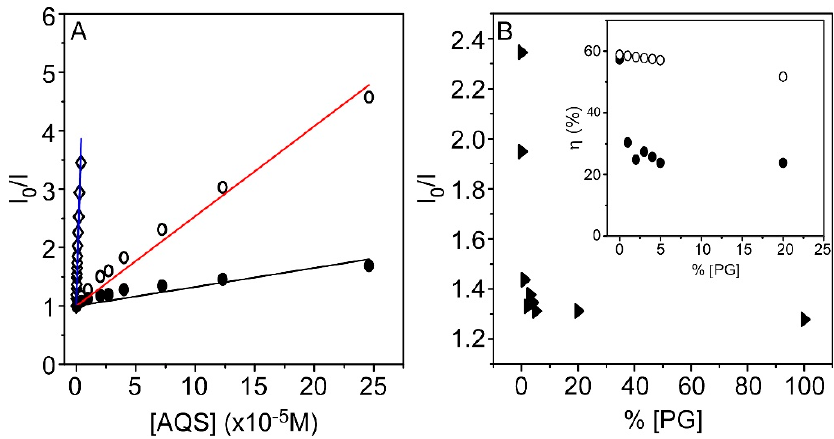
Figure 4. ( A ) Stern-Volmer plots for quenching of HTMA-PFBT (1.5 µM) by AQS in buffer (hollow diamonds) and in LUVs of PG (black circles) and PC 1 mM (hollow circles). ( B ) Quenching induced by AQS (100 µM) in the fluorescence intensity of HTMA-PFBT in samples containing PC LUVs with increasing concentrations of PG LUVs. Inset: Experimental quenching efficiency versus increased PG vesicles percentage (black circles) compared with the theoretical quenching efficiency determined if HTMA-PFBT had the same preference for both types of vesicles (hollow circles).